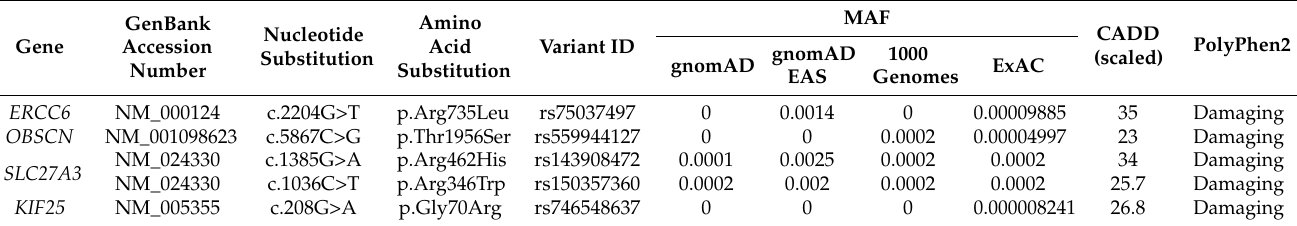
Table 3. Identified variants and their pathogenicity